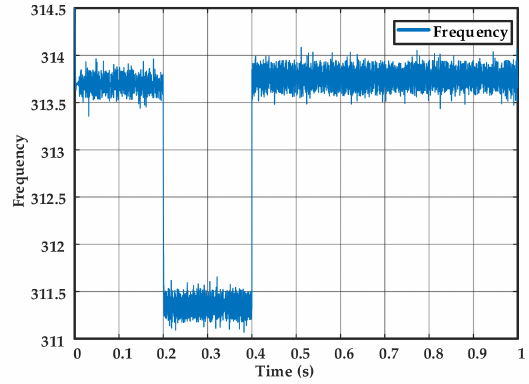
Figure 7. Frequency (angular)